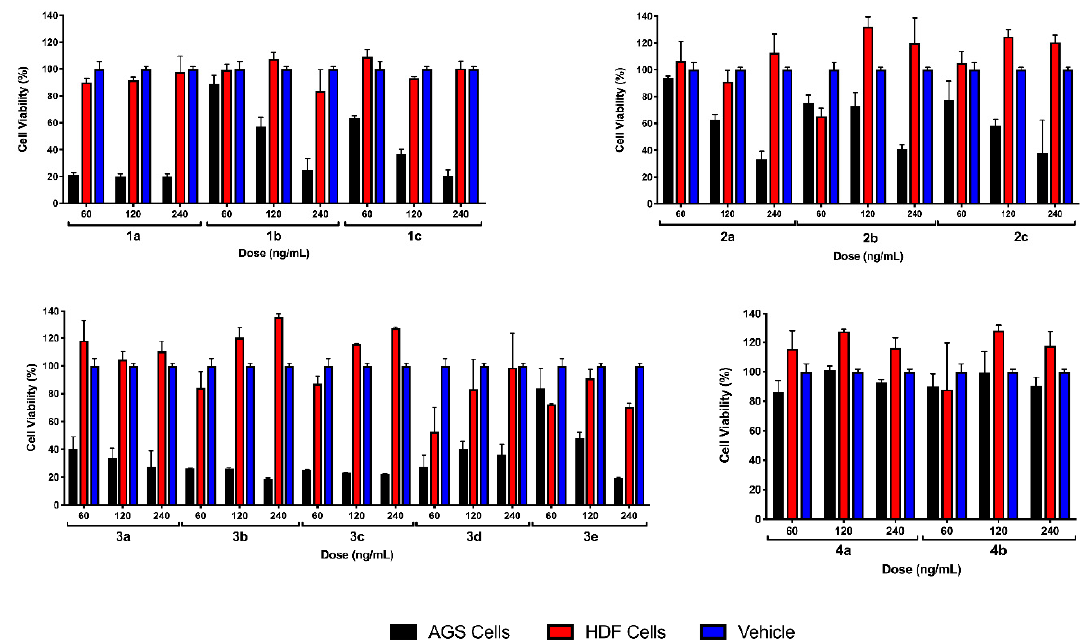
Figure 2. Comparison of human gastric adenocarcinoma (AGS) and human dermal fibroblast (HDF) cells lines viability (%) against Myrtenyl derivates by Sulforhodamine B assay. Three different concentrations of Myrtenyl derivates were analyzed after 24 h of drug treatment in AGS and HFD cells, and cell cytotoxicity was determined by Sulforhodamine B assay. Vehicle: 1% Methanol. The data represent mean ± standard deviation of triplicated determinations in three independent experiments.